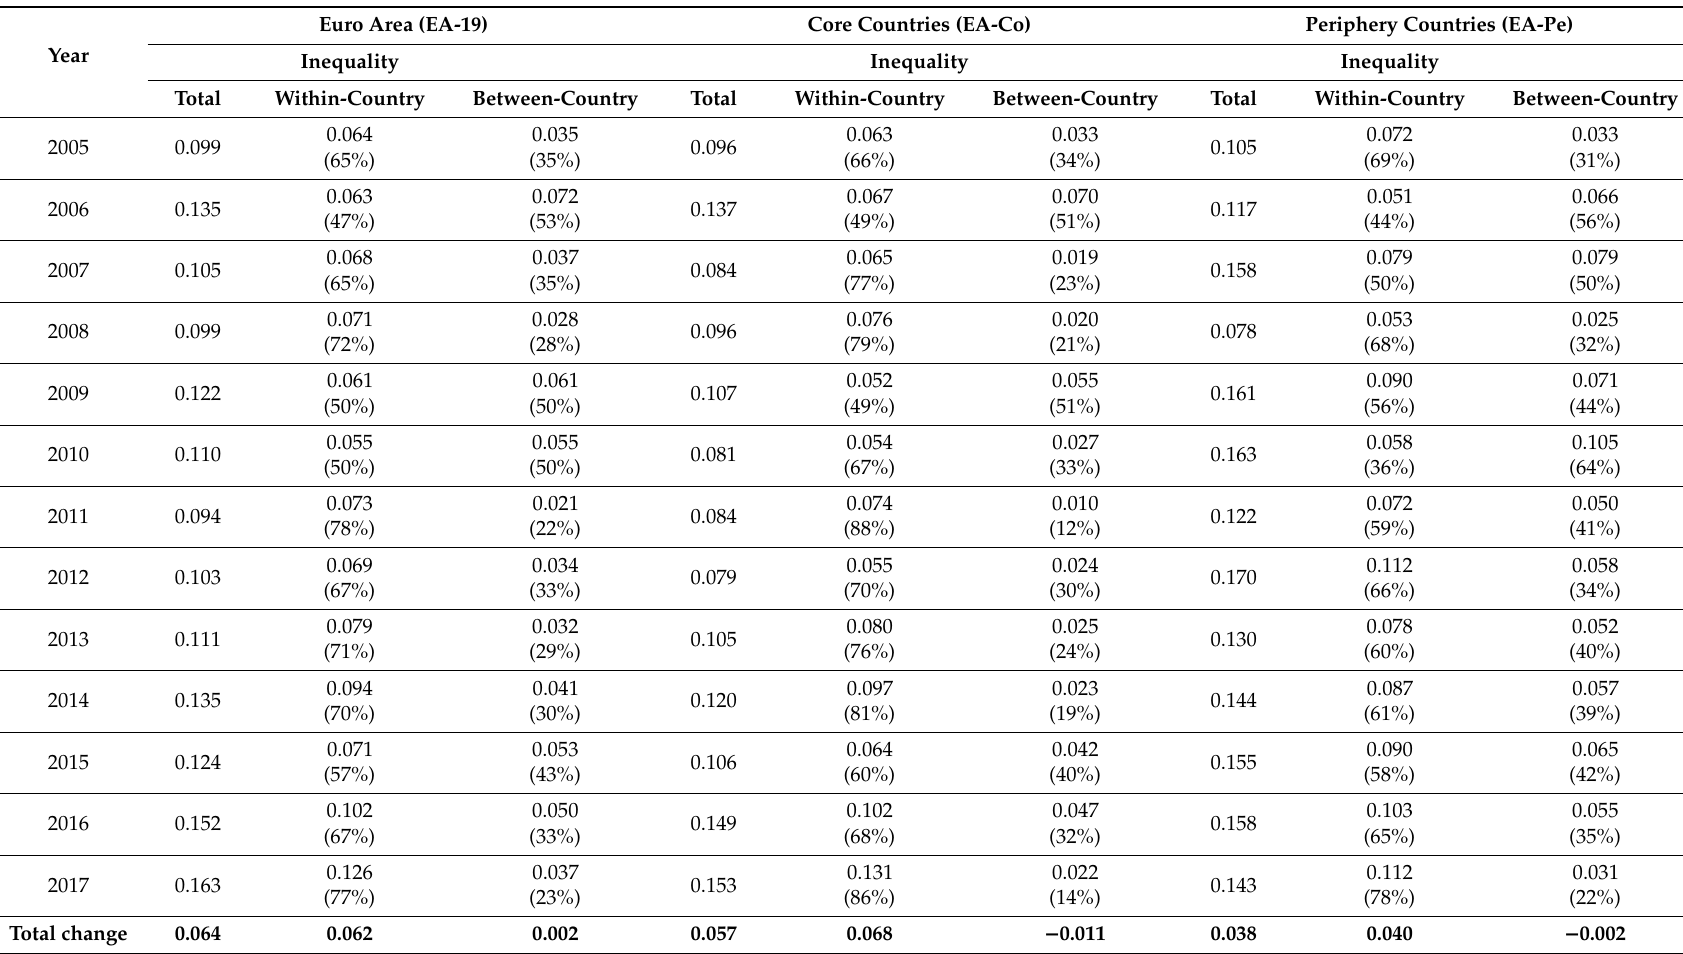
Table 6. Evolution and decomposition of the Theil inequality index for the Lerner index of market power into within-country and between-country